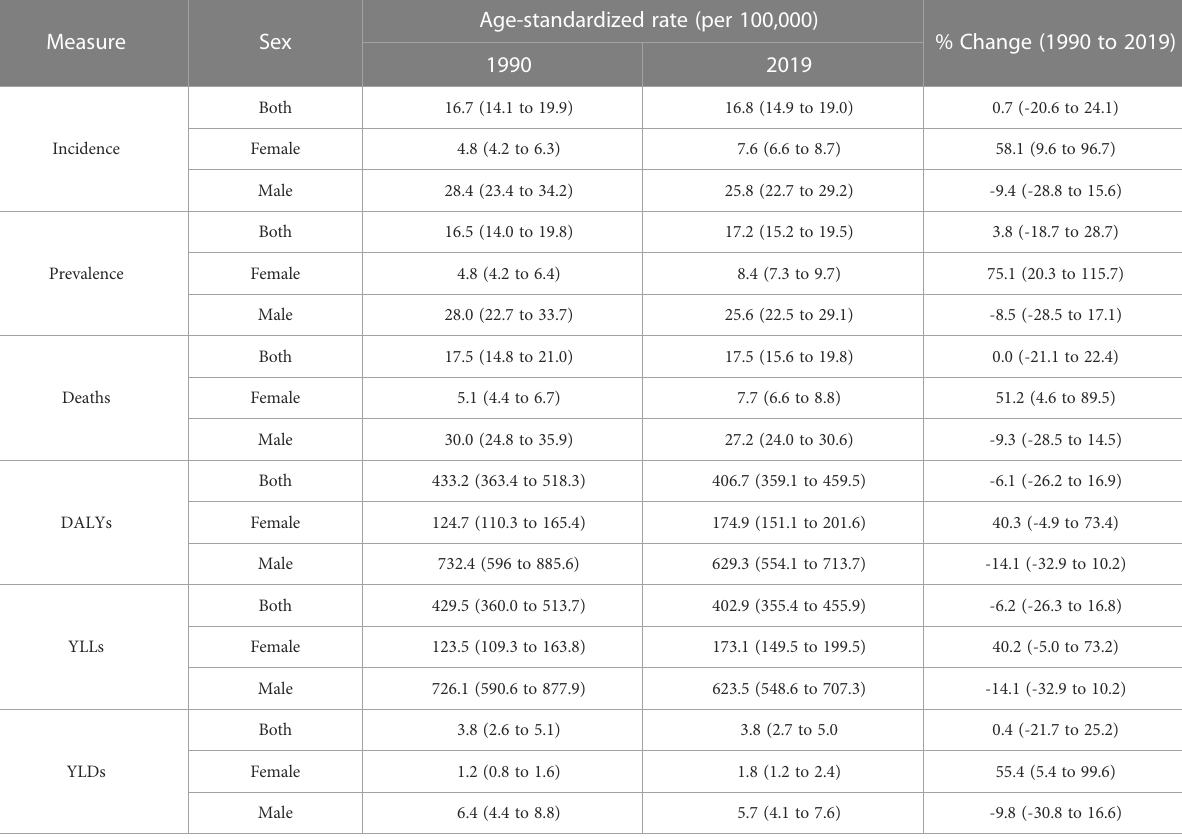
TABLE 1 Age-standardized rate (per 100,000) of incidence, prevalence, deaths, DALYs, YLLs, and YLDs in region by sex in 1990 and 2019 with their percent changes.